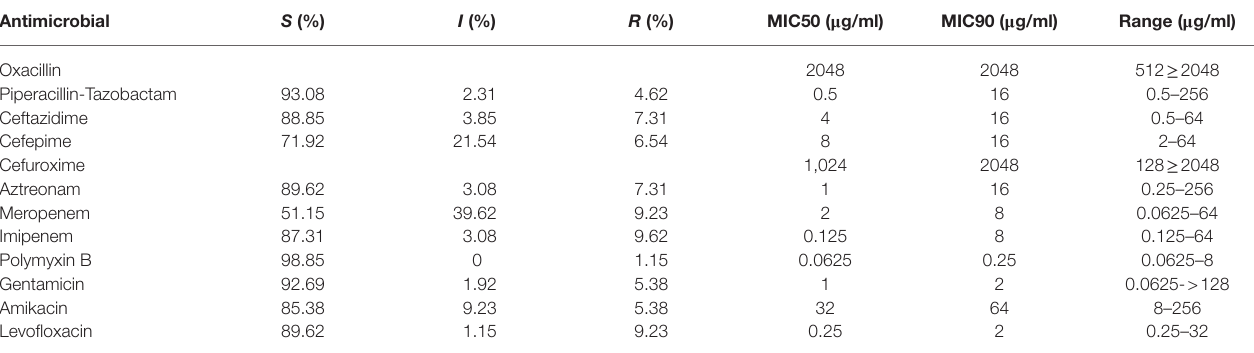
TABLE 2 | Antimicrobial susceptibility of the 260 P . aeruginosa isolates against 12 antimicrobials tested. Antimicrobial S